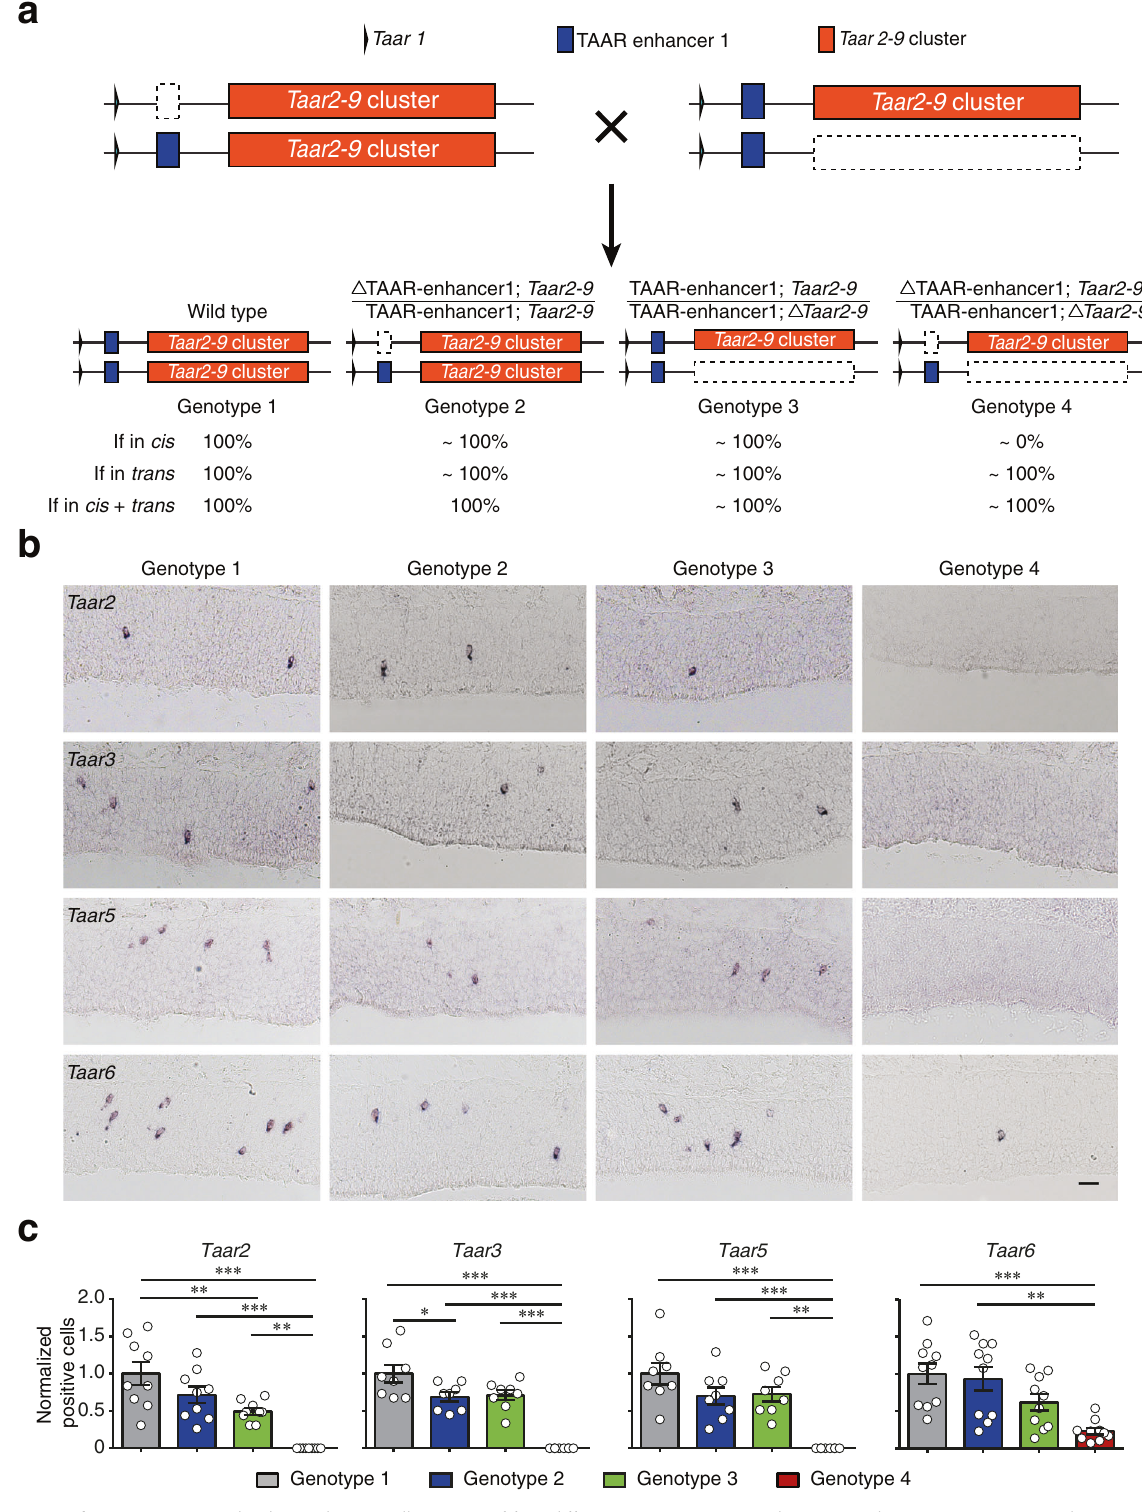
Fig. 8 TAAR enhancer 1 operates in cis . a Schematic illustration of four different mouse genotypes by crossing heterozygous TAAR enhancer 1 knockout mice with heterozygous Taar2-9 cluster knockout mice. According to the assumption that TAAR enhancer 1 functions in cis , in trans , or in cis plus trans , the hypothetical percentage of positive cell numbers in different genotypes were indicated by normalizing to wild-type (genotype 1) mice (set as 100%). b Representative images of Taar2 , Taar3 , Taar5 , and Taar6 expression in four different genotypes is indicated by using a single-color in situ hybridization. Scale bar = 25 μ m. c The numbers of OSNs expressing Taar2 , Taar3 , Taar5 , and Taar6 were quanti fi ed and the percentage of positive cell numbers normalized to wild type was plotted. Data are presented as mean values ± SEM ( n = 9 for Taar2 detection, n = 8 for Taar3 detection, n = 8 for Taar5 detection, n = 10 for Taar6 detection). In c , * p < 0.05, ** p < 0.01, *** p < 0.001, by one-way ANOVA and post hoc Tukey ’ s